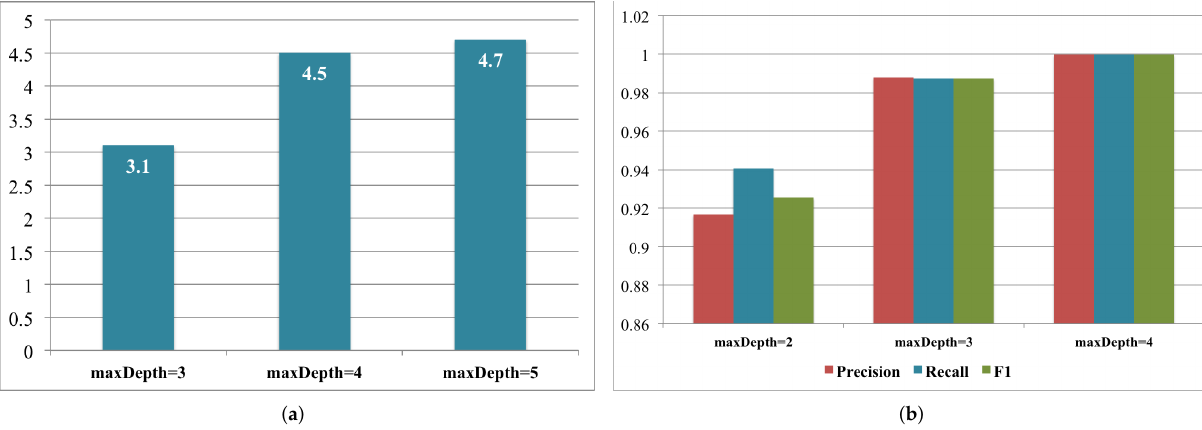
Figure 12. Training time and accuracy of the classification models. ( a ) Training time; ( b )